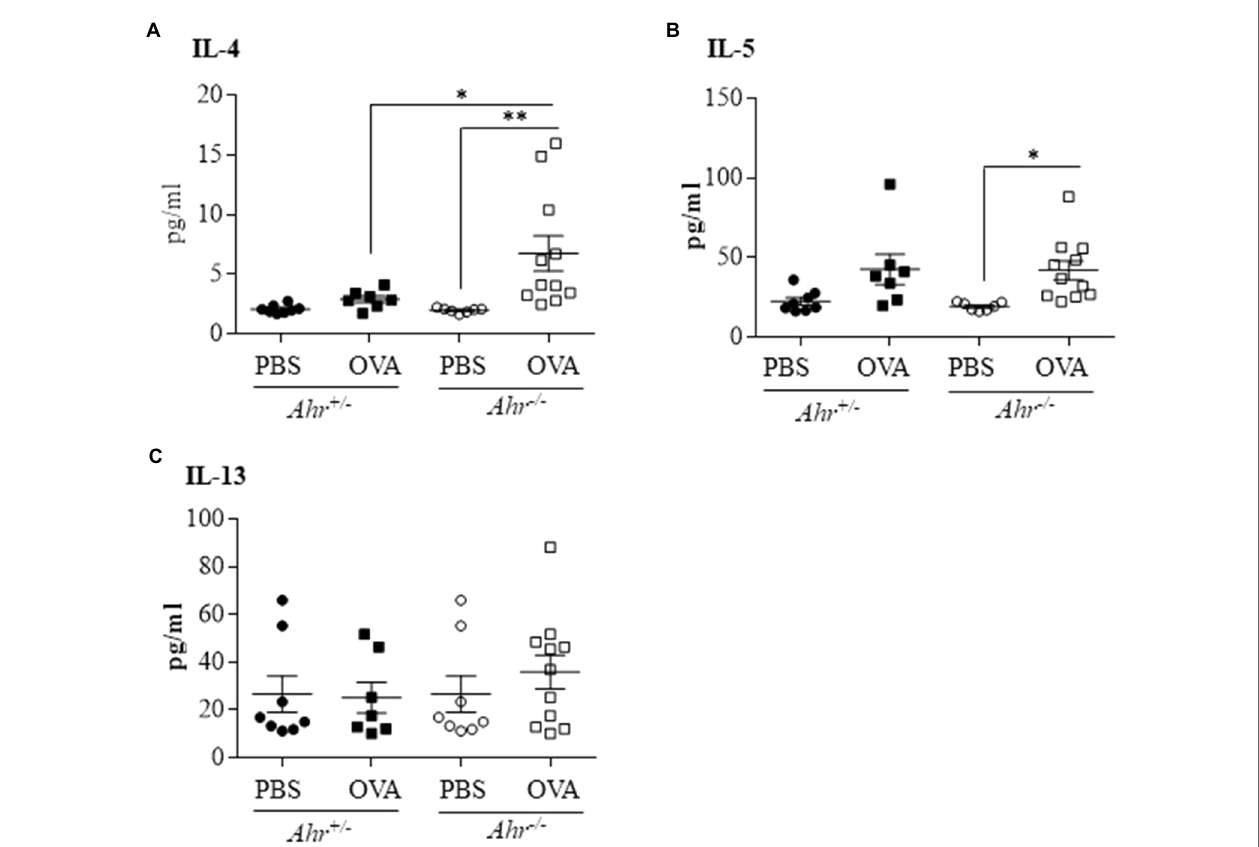
FIGURE 4 | Ahr − / − mice exhibit increased levels of IL-4 and IL-5 following OVA challenge. Protein levels of interleukin-4 (IL-4), IL-5, and IL-13 were measured in the BAL fluid by multiplex assay. (A) IL-4 – there was a significant increase of IL-4 in the Ahr − / − mice exposed to OVA compared with the Ahr − / − mice exposed to PBS (** p = 0.0095) and to the Ahr+/ − mice exposed to OVA (* p = 0.0466). (B) IL-5 – there was a significant increase of IL-5 only in the Ahr − / − mice exposed to OVA (* p = 0.0396). (C) IL-13 – IL-13 was not significantly increased between any of the groups. Results are expressed as the mean ± SEM; values for individual mice are